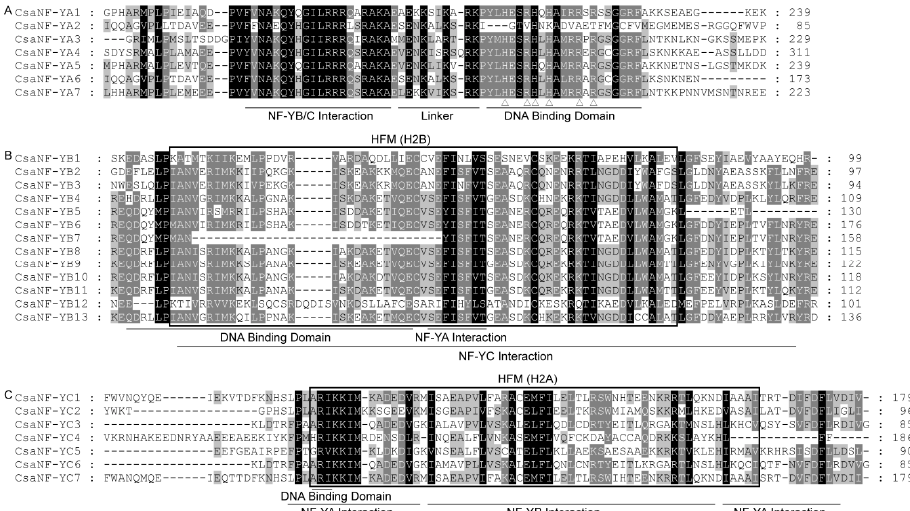
Figure 3. Multiple alignments of CsaNF-Y protein sequences. ( A ) Multiple alignments of CsaNF-YA protein sequences. ( B ) Multiple alignments of CsaNF-YB protein sequences. ( C ) Multiple alignments of CsaNF-YC protein sequences. The evolutionarily conserved domains including the DNA-binding domains and the NF-Y subunit interaction domains are underlined. The histone-fold motif (HFM) of the core histones (H2A and H2B) are boxed. Three histidine (H) and three arginine (R) residues in the DNA binding domain of the CsaNF-YA proteins are marked with triangles.